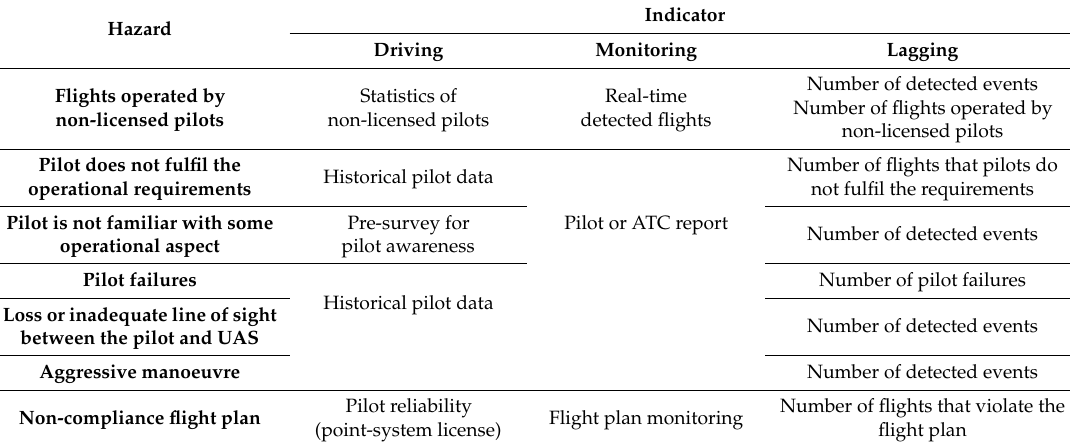
Table 5. Safety indicators regarding operator training, experience and performance.